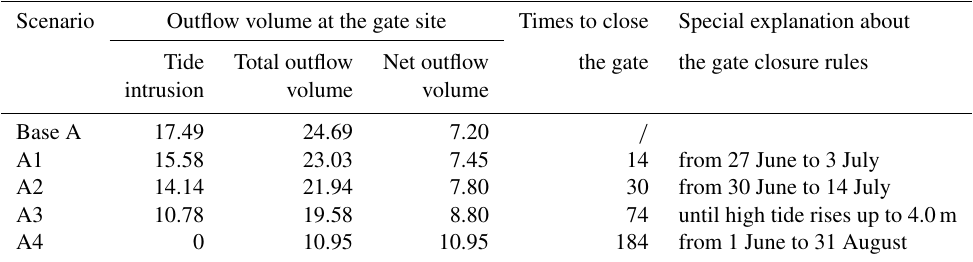
Table 5. Summary of tide intrusion and outflow volume at the site of the proposed gate from June to August in 1999 under the five scenarios considered in this study (unit: billionm 3